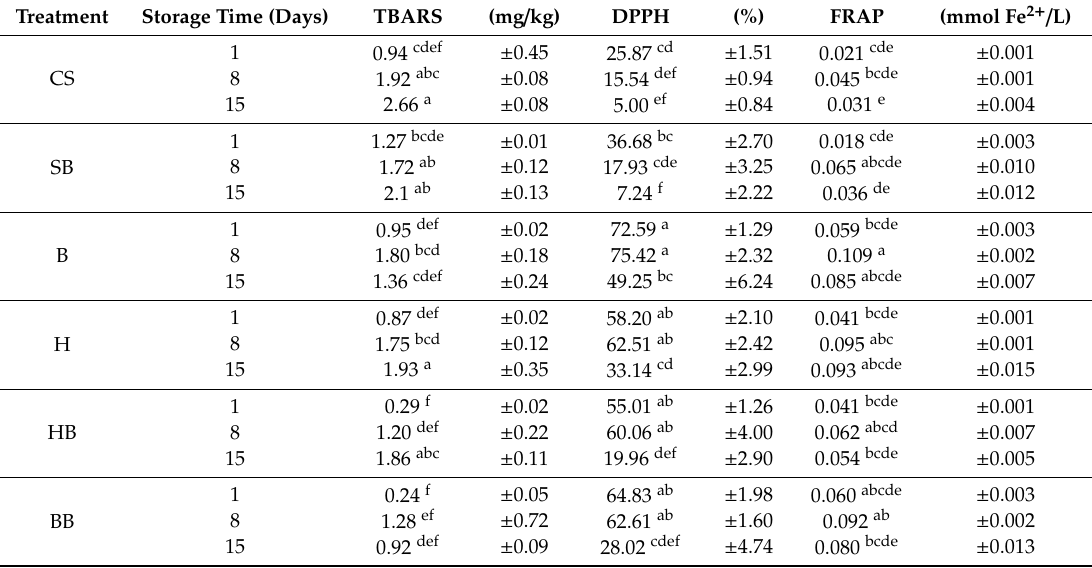
Table 3. TBARS, DPPH and FRAP values in samples during storage (mean values ± standard errors (SE). Treatment Storage Time (Days)